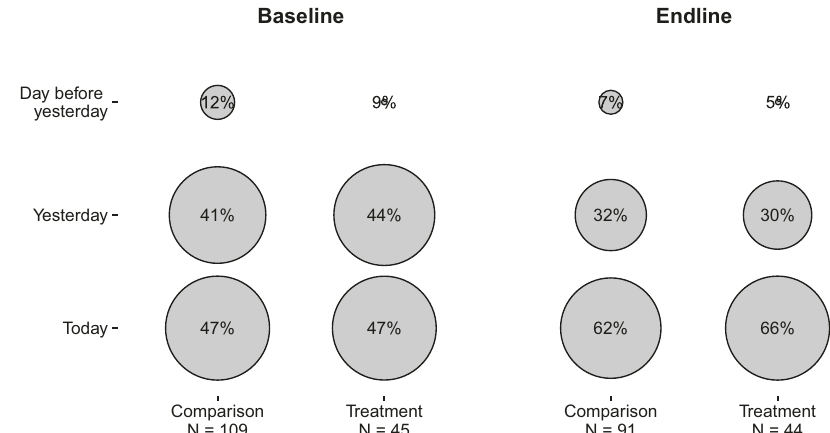
Fig. 3 Self-reported water storage behavior. Self-reported collection day of stored water in the home, by group and study phase, with area of circle representing relative proportion within each column.